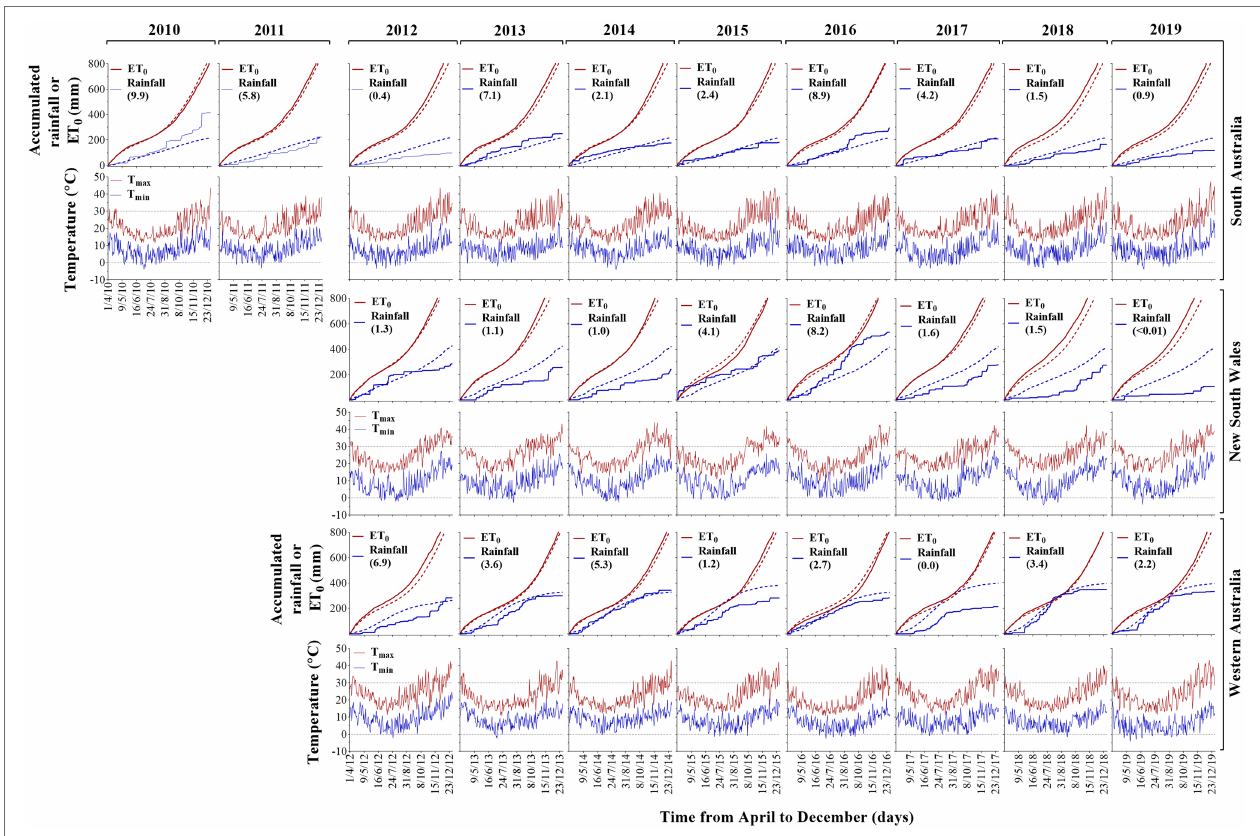
FIGURE 1 | Accumulated rainfall, evapotranspiration (ET), daily maximum and minimum air temperature as a function of time from April to December between 2010 and 2019 growing seasons in SA, NSW and WA. Solid and dotted lines correspond to in-crop and long-term values [from 1960 up to the previous year for each frost expression experiments (FEE)] of accumulated ET (red color) and accumulated rainfall (blue color), respectively. Horizontal dotted black lines are temperature values at 30 ° C or 0 ° C. Values between parentheses represent rainfall deciles.